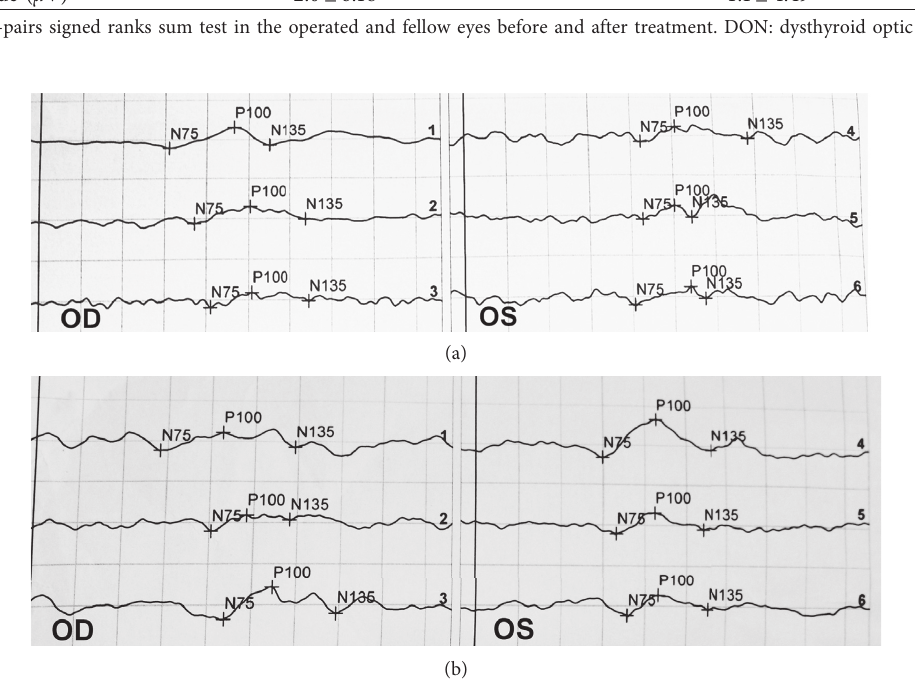
Figure 3: Visual evoked potentials (VEP) testing showed latencies and amplitudes before and after orbital decompression on the left eye combined with methylprednisolone pulse therapy (MPT). (a) Prolonged latencies and reduced amplitudes were shown in both eyes before orbital decompression on the left eye combined with MPT. (b) Latencies and amplitudes restored in operated eyes after orbital de- compression on the left eye combined with